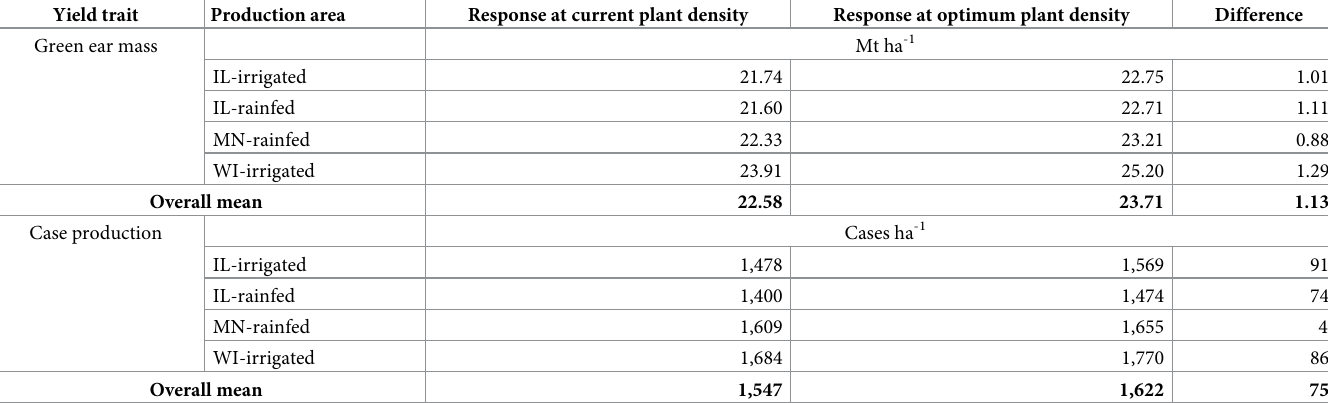
Asterisks represent significant differences at α = 0.05 based on pairwise